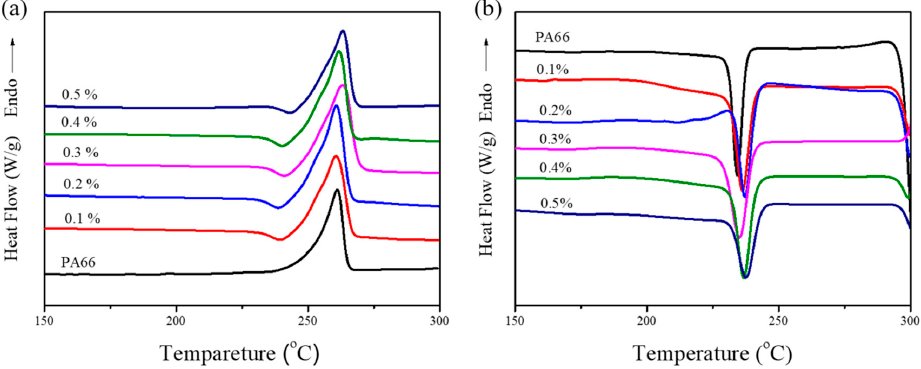
Figure 13. Differential scanning calorimeter ( DSC) curves of the melting ( a ) and cooling ( b ) behavior in pure PA66 and EG/PA66 composites.